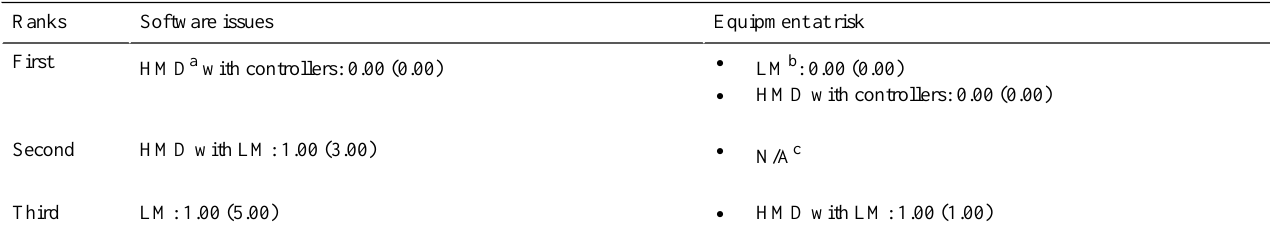
Table 3. Ranking of participants’performance to manipulate objects.